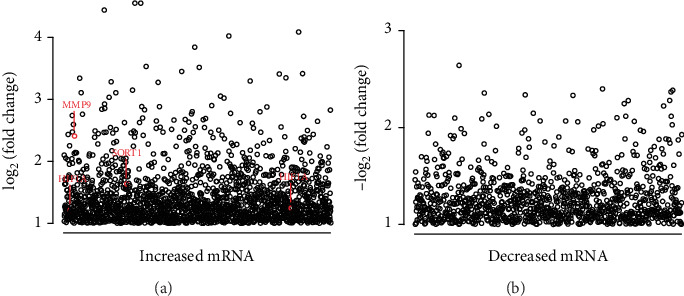
Differential mRNA expression between MMD patients and controls. Log2FC > 1 (P < 0.05) (MMP9, SORT1, and HIF1α are marked in red). X-axis shows that the probes of mRNA are arranged in sequence.